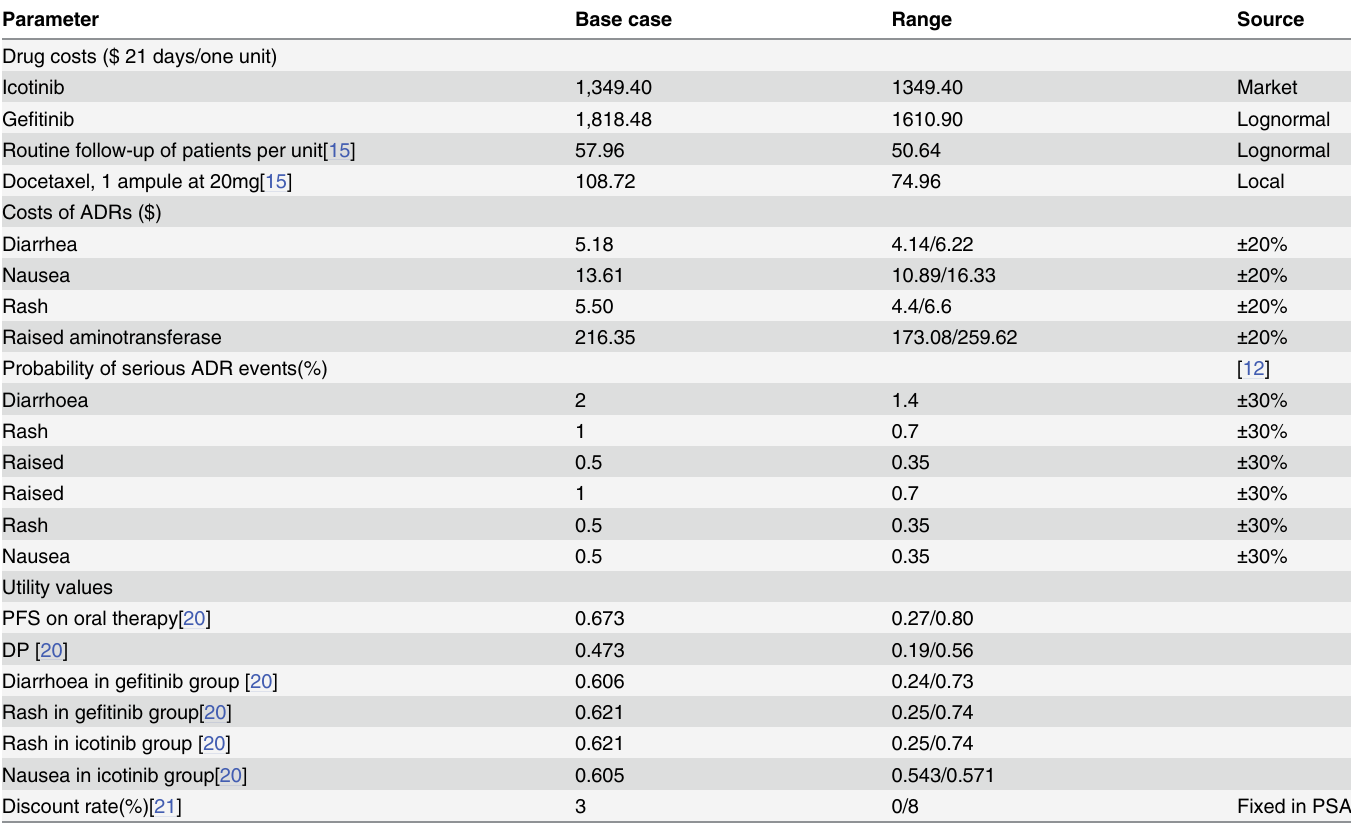
Table 1. Baseline costs, risks and utility values of icotinib and gefitinib in advanced NSCLC patients in China. Data are in 2014 US dollars.